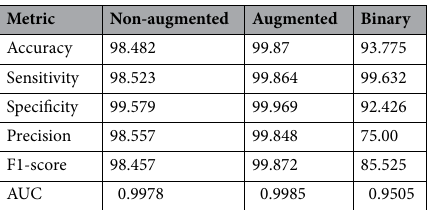
Table 9. Comparison of the average performance metrics of different datasets.